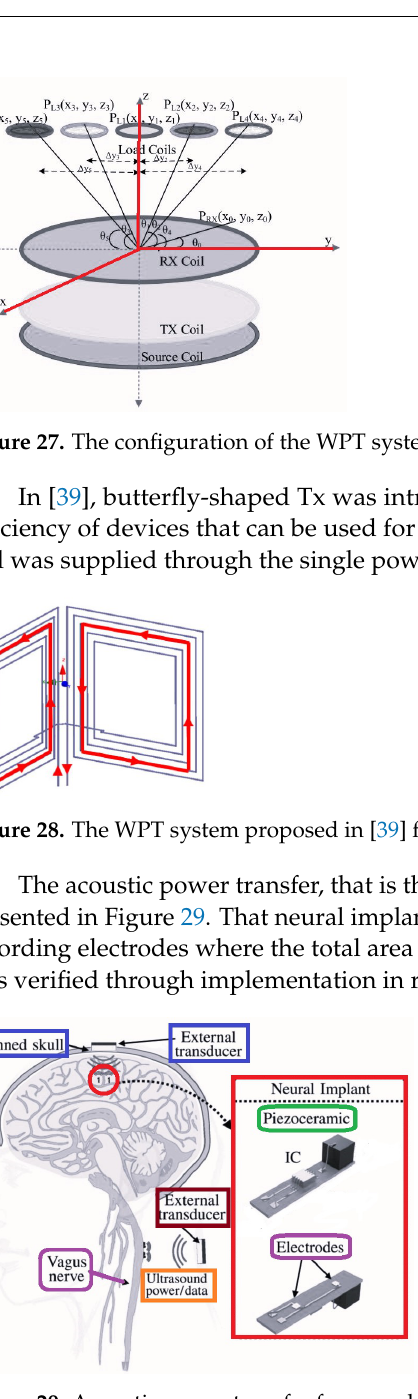
Figure 29. Acoustic power transfer for neural